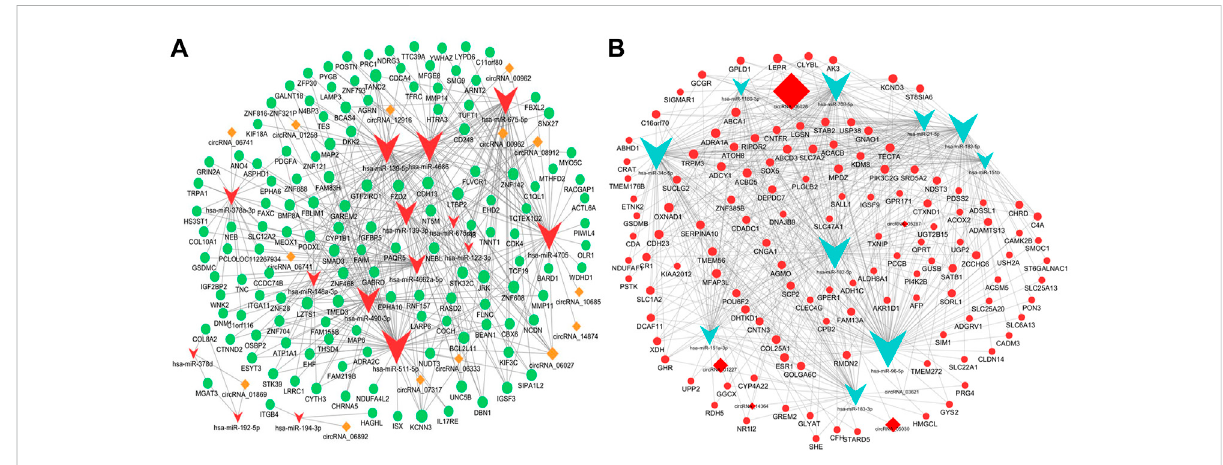
FIGURE 6 Construction of the ceRNA networks. (A) The upregulated circRNA-mediated ceRNA network. (B) The downregulated circRNA-mediated ceRNA